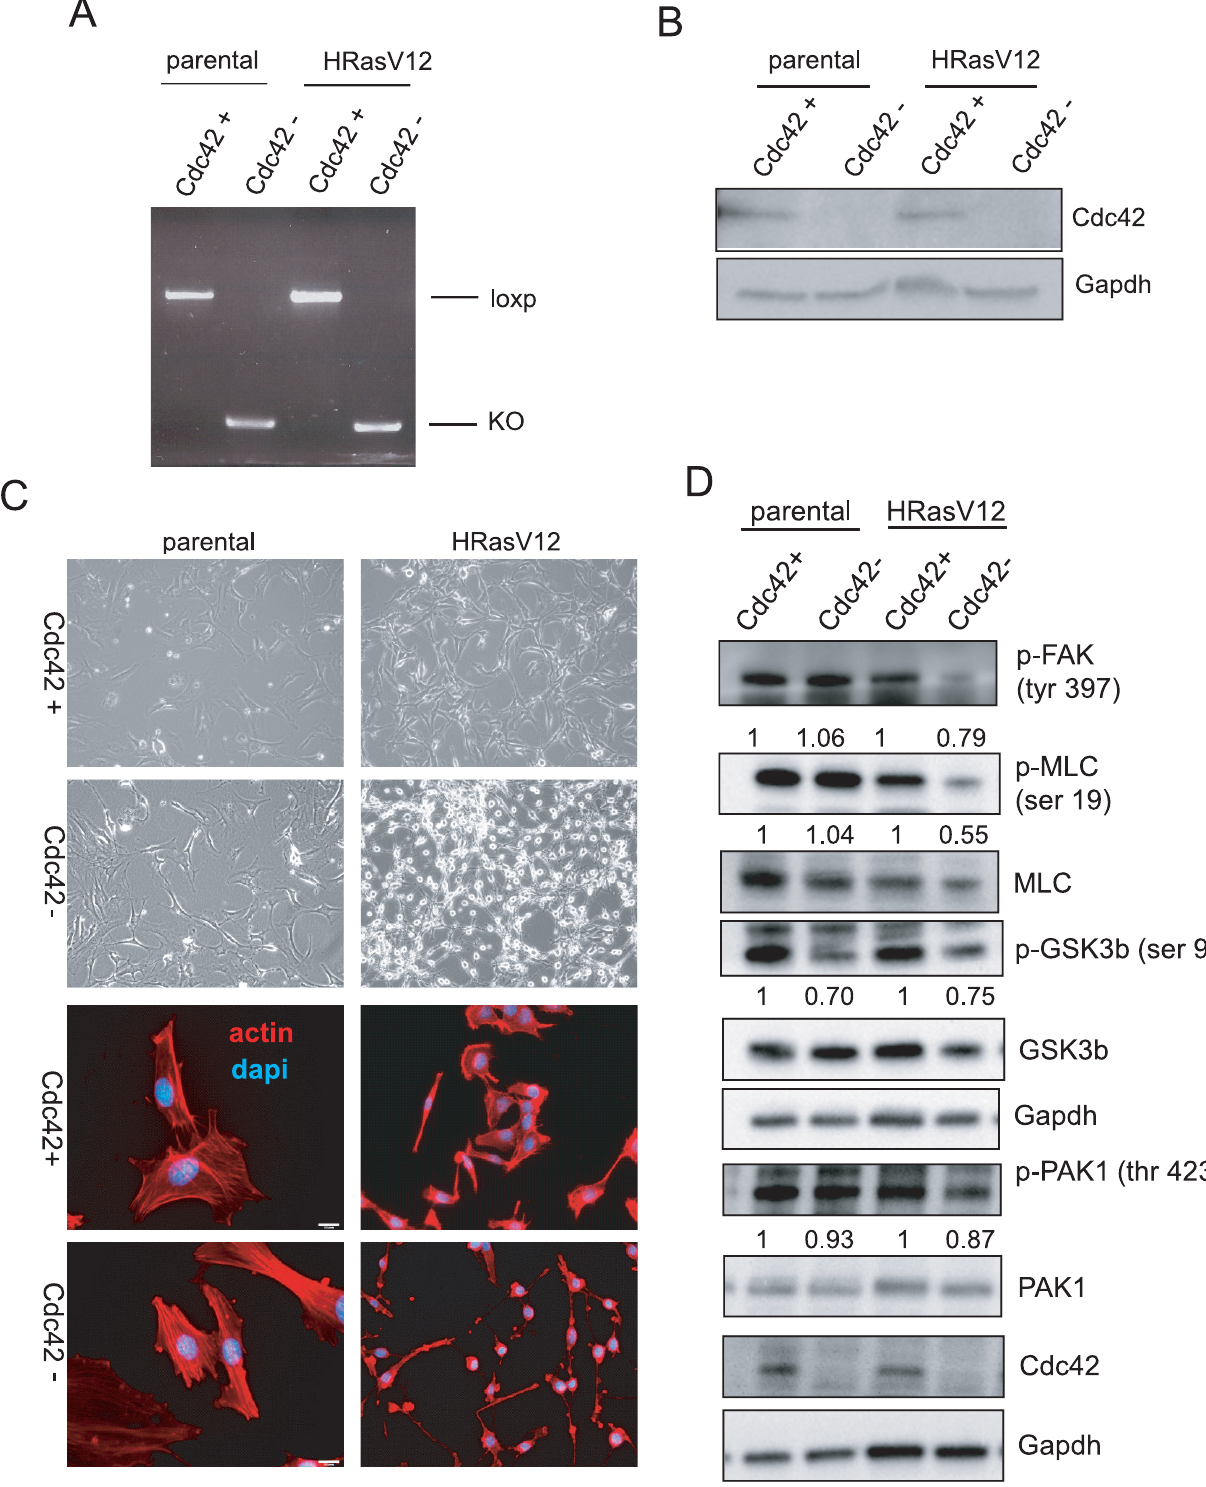
Figure 2. Cdc42 deletion in HRasV12 transformed cells results in dramatic morphological changes and deregulation of Cdc42 effector pathways. ( a ) Recombination of the cdc42 locus following addition of Cre recombinase was monitored by genomic PCR detecting the loxp allele. ( b ) Recombination of the cdc42 locus correlates with loss of Cdc42 protein expression as determined by western blot analysis. ( c ) Cultured HRasV12 cells and non-transformed cells were visualized 4 days following cdc42 deletion by bright field microscopy (upper 4 panels). Cells were fixed and stained with rhodamine-phalloidin and 4,6-diamidino-2-phenylindole (DAPI) to visualize actin structures. ( d ) Cell lysates from Ad-GFP-Cre and control infected cells were immunoblotted for proteins involved in effector signaling downstream of activated Cdc42.